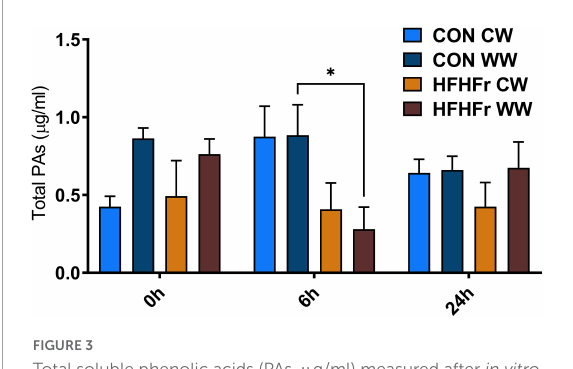
FIGURE3 Total soluble phenolic acids (PAs, µ g/ml) measured after in vitro batch culture fermentation. The system was inoculated with 1% (v/v) fecal slurry from control (CON) or HFHFr animals supplemented with 1% (w/v) digested control wheat (CW) or digested wholegrain wheat (WW). The data show the PA levels in fermented samples at baseline (0 h), 6 and 24 h. Data are presented as mean ± SEM ( n = 3), ∗ P < 0.05 (two-way ANOVA and Sidak’s multiple comparison’s